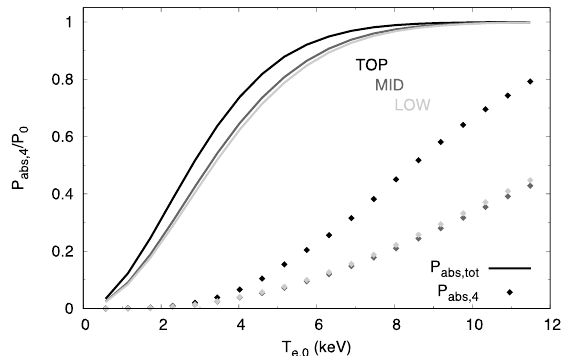
Fig. 7a. Total and power absorbed by n=4 harmonic resonance for n e,0 =3.2∙10 19 m -3 ; solid lines corresponds to lines in Fig. 5.